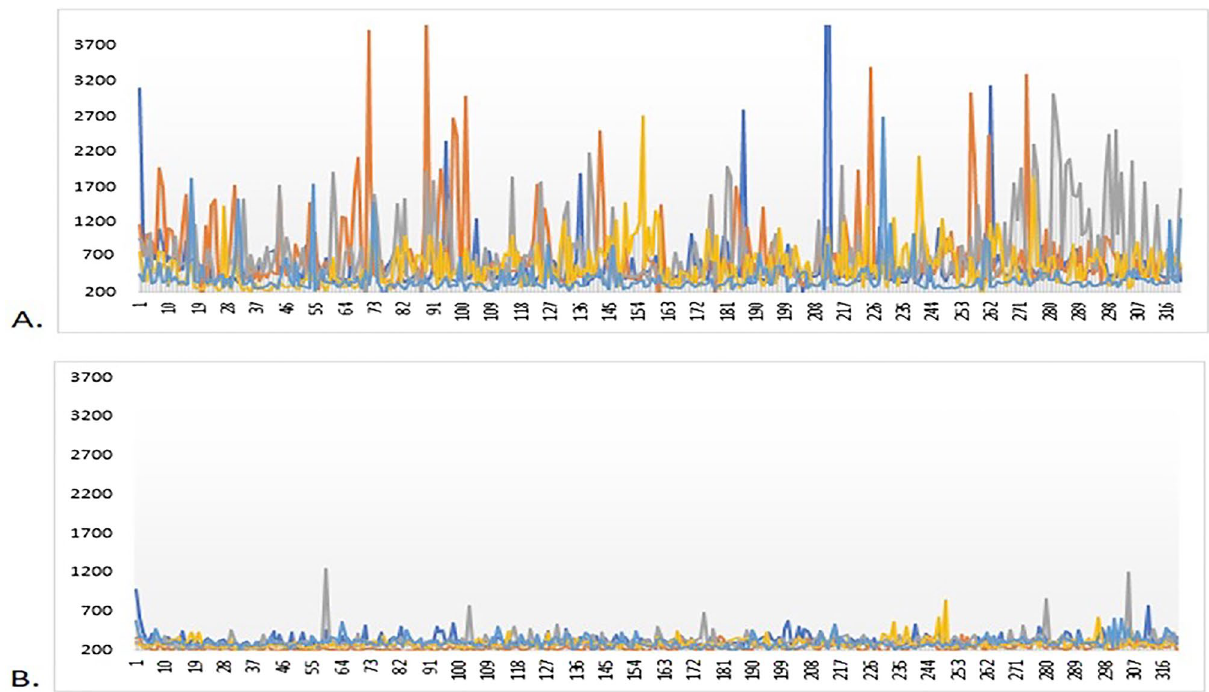
Figure 2. Comparison between variability of RTs in 5 PCS patients ( A ) and 5 HC ( B